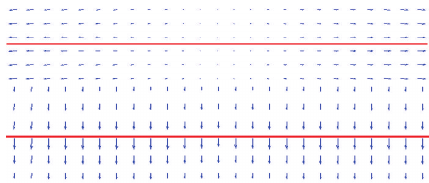
Figure 6: External force field at the entrance of deep concavity.